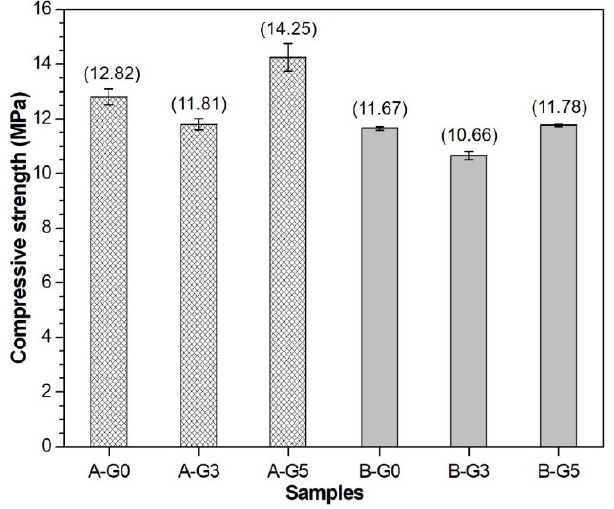
Figure 10. 24 h compressive strength of CSA cement paste containing 0% (G0), 3% (G3), and 5% (G5) gypsum. A: w/s ratio of 0.5; B: w/s ratio of 0.55.